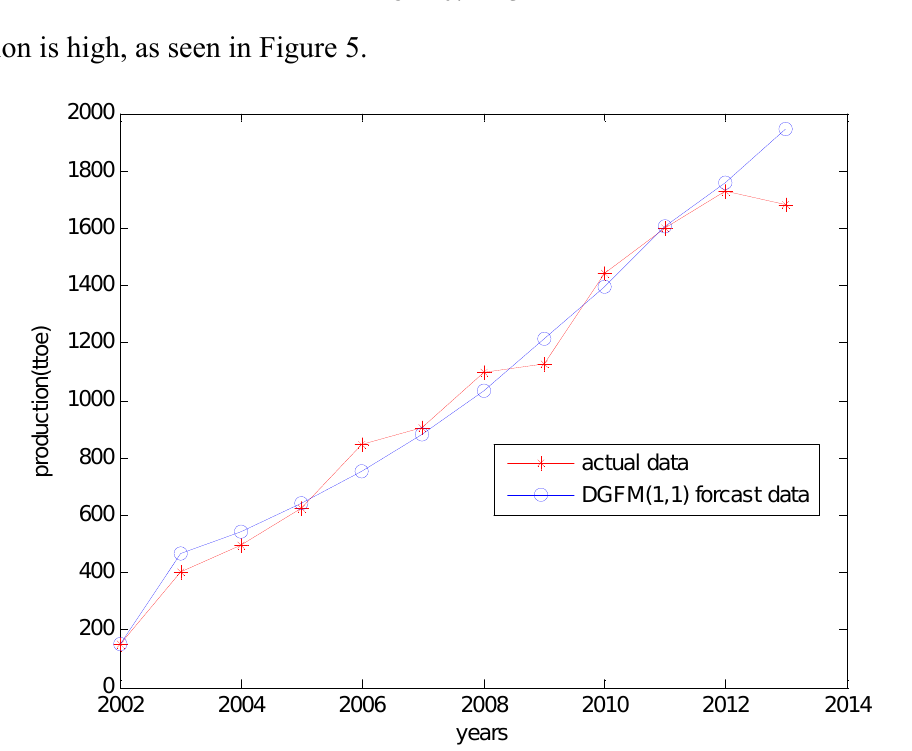
Figure 5. Prediction map for biofuel production using the dynamic grey fuzzy Markov DGFM (1,1) prediction